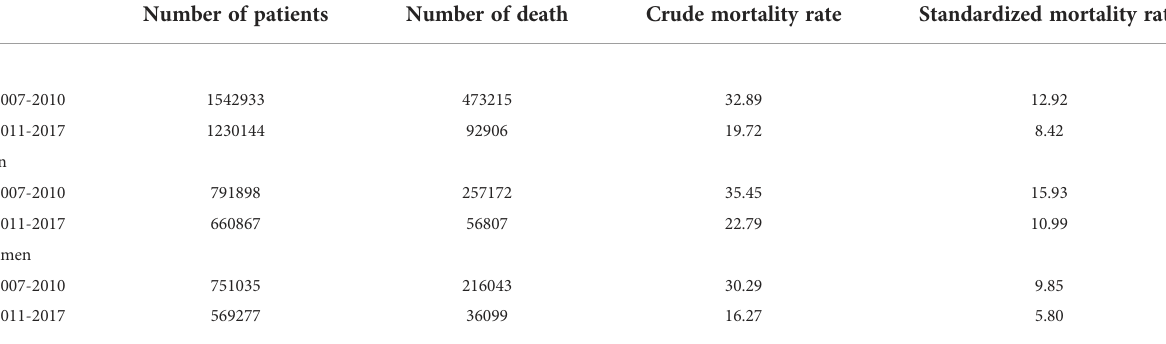
TABLE 2 All-cause mortality rates in diabetes patients by year of diabetes diagnosis (2007-2010 versus 2011-2017, follow up to 2018). Number of patients Number of death Crude mortality rate Standardized mortality rate